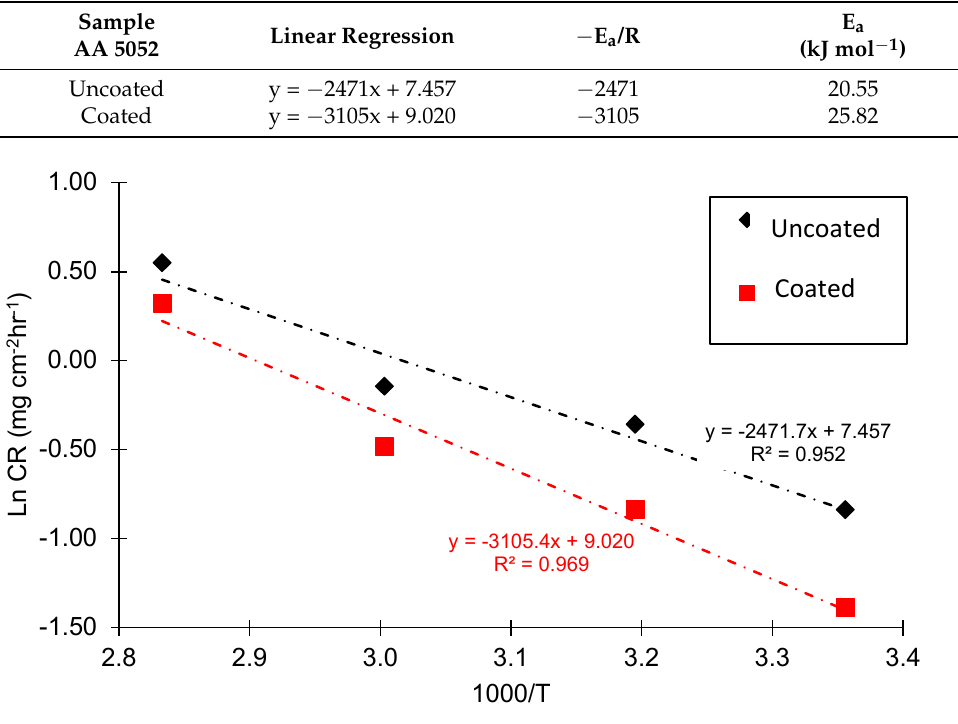
Figure 1. Plot graph of Ln CR vs. (1/T) metal AA5052 uncoated and coated with chitosan inhibitor for 20 min EPD time.